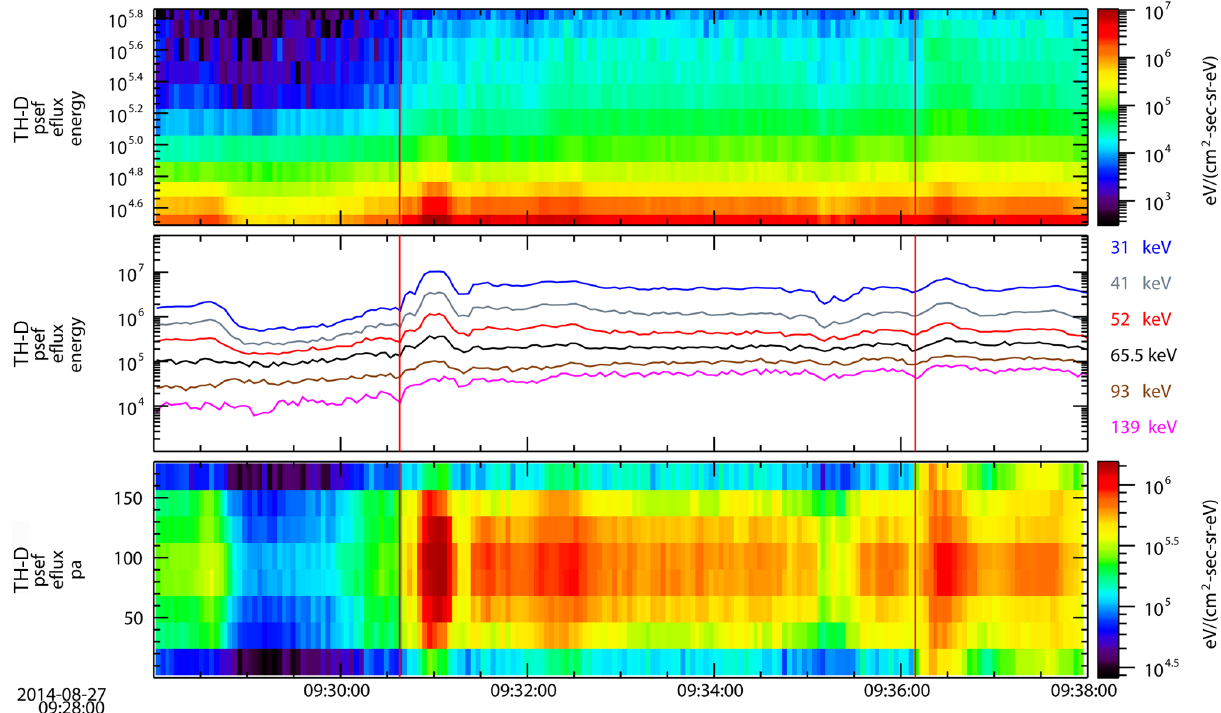
Figure 5. The energetic electrons energy flux (psef) and pitch angle (pa) distribution of energetic electrons detected by the SST on-board TH-D in 3s time resolution. The red vertical lines mark the times 09:30:38 and